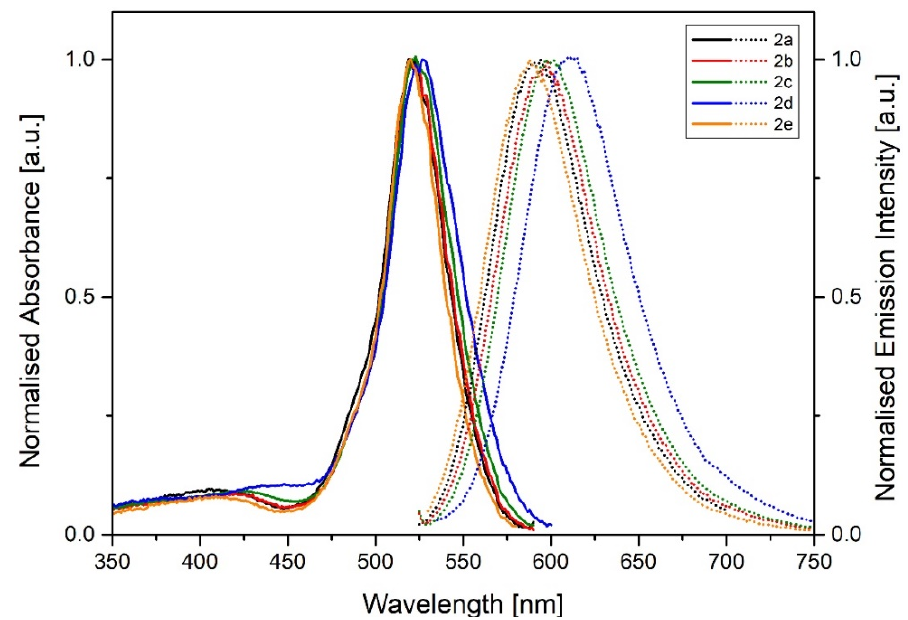
Figure 1. Absorbance and emission spectra of the BODIPY compounds ( 2a – 2e ) in toluene. Table 1. Photophysical properties of BODIPY compounds ( 2a – 2e ) and the standard BODIPY FL.